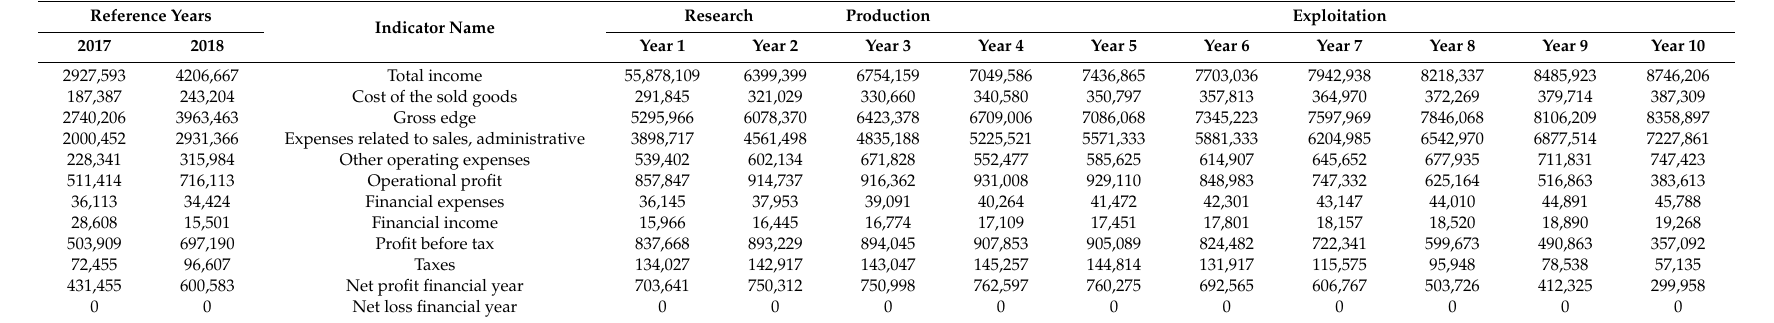
Table 5. Cost elements and revenues in the case of project implementation, the profit and loss